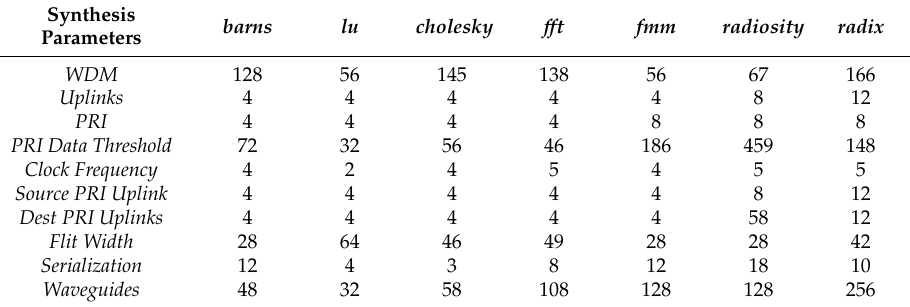
Table 4. ACO Synthesis Results.